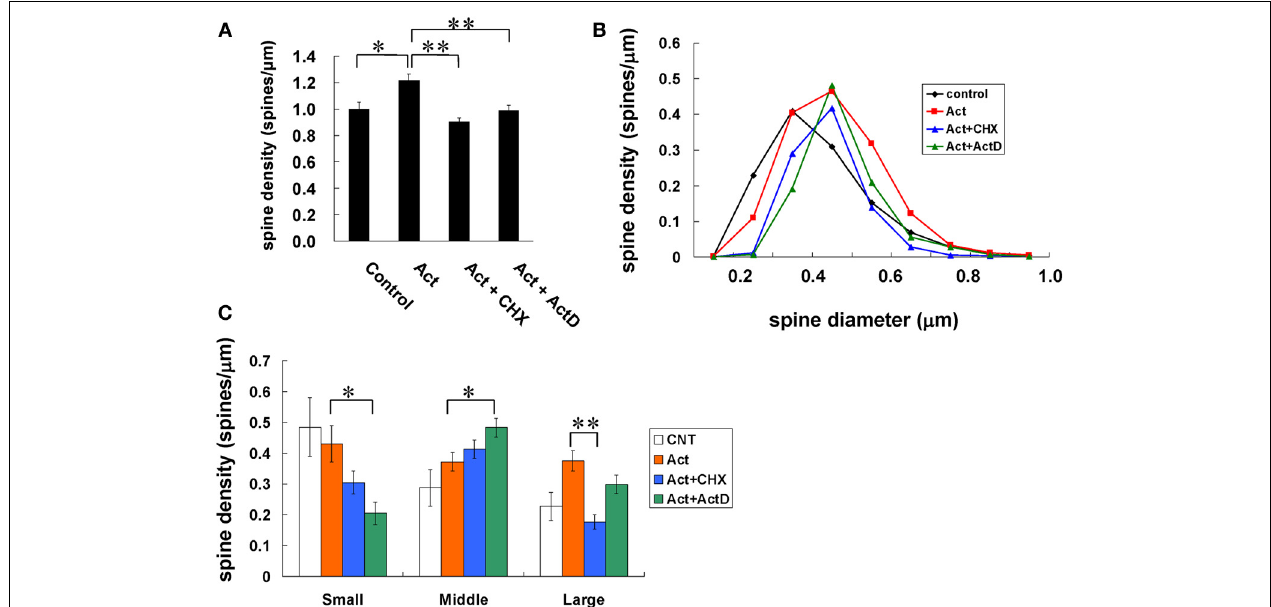
(closed orange square), Act + CHX (closed blue triangle), and Act + ActD (closed green triangle). (C) Density of three subtypes of spines. Abbreviations are same as in (A) . Vertical axis is the average number of spines per 1 μ m of dendrite. From left to right, small-head spines (Small), middle-head spines (Middle), and large-head spines (Large). ACSF without drugs (open column), Act (orange column), Act + CHX (blue column), Act + actD (green column). Statistical significance is calculated against activin treated group in each spine subtypes and comparisons reached significance are indicated by stars. The significance yielded P < 0 . 05. ∗ P < 0 . 05, ∗∗ P < 0 . 01. In (A,C) results are reported as mean ± s.e.m. For each drug treatment, we investigated 3 rats, 6 slices, 12 neurons, 24 dendrites and 1100–1800 spines. For control, we used 5 rats, 8 slices, 16 neurons, 31 dendrites and approx. 1700